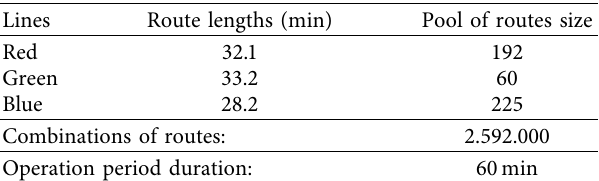
Table 1: Network characteristics: length of lines for the standard route in the TFS; number of routes in the pool of routes for each line in the operation period.